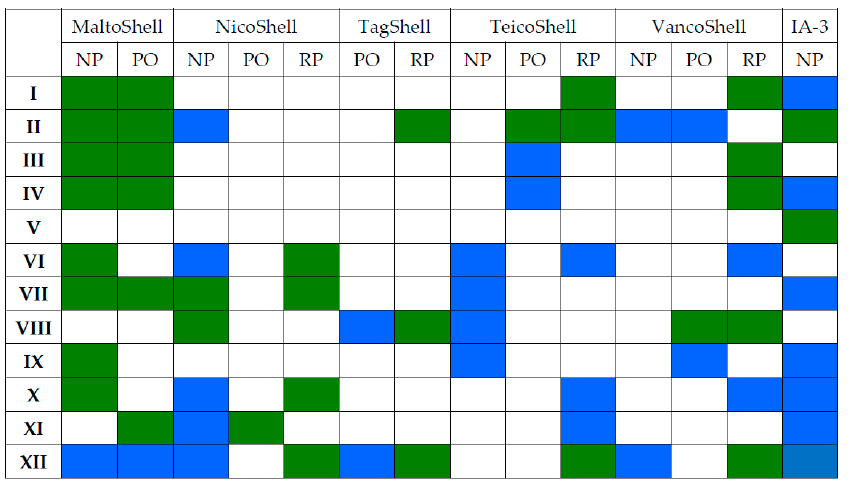
Figure 2. Heat map or score card of the separation of the enantiomers of the 12 azole compounds on the Table 1 columns with the different mobile phase modes. NP: normal mobile phase; RP: reversed polar aqueous mobile phase; PO: polar organic waterless mobile phase. Green color: Rs > 1.5; blue color: 0.4 < Rs < 1.5; no color: Rs < 0.4.